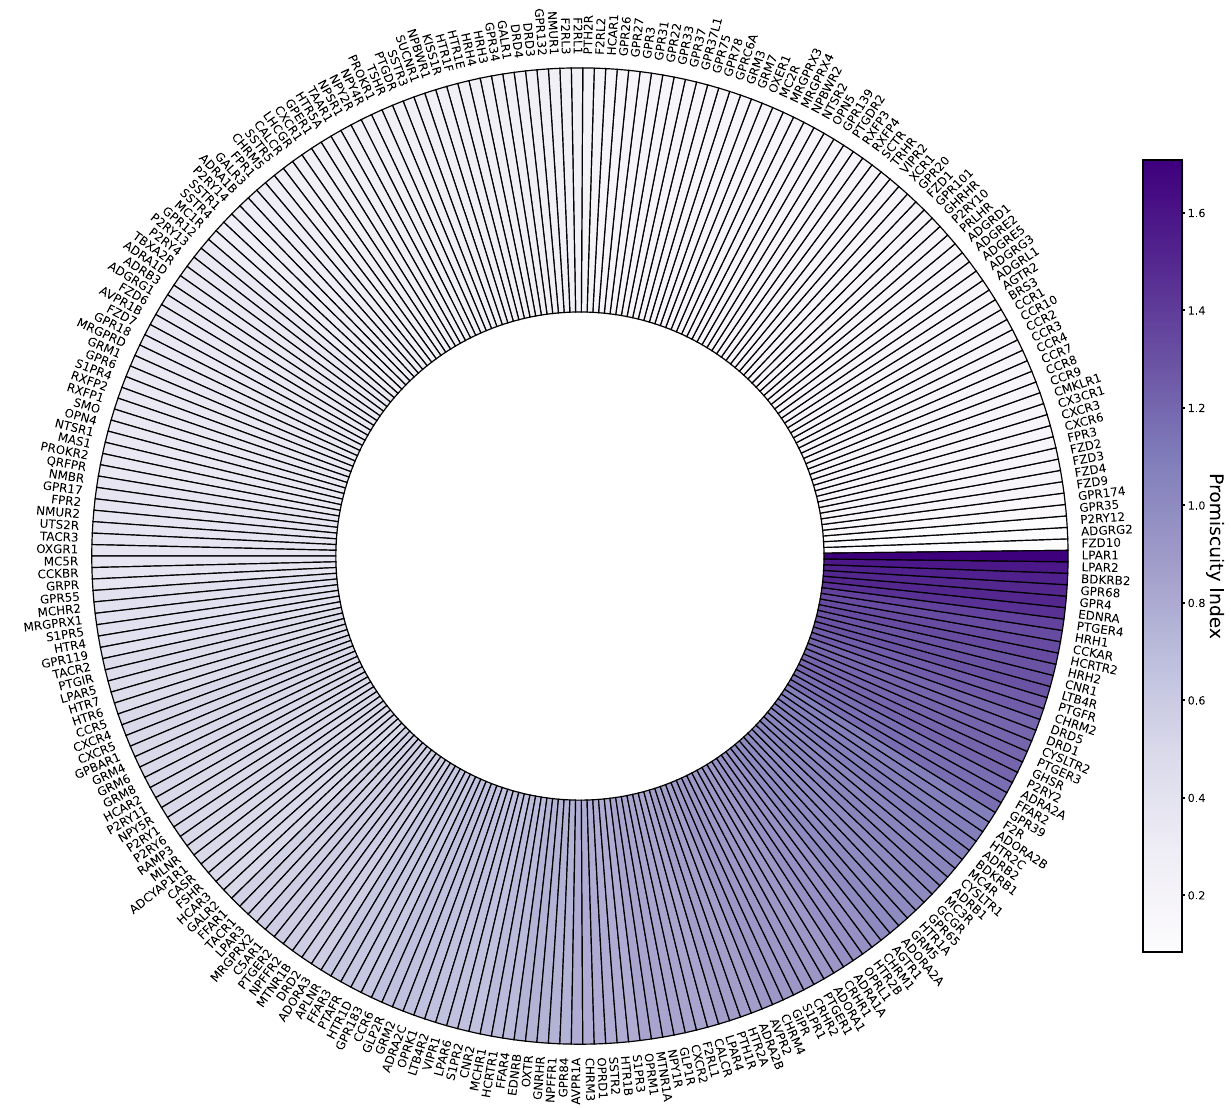
Fig. 1 | GPCRs exhibit a spectrum of coupling strength to G-proteins; from selectiveinteractionwith asingleGprotein to promiscuouscoupling acrossG protein subfamilies. GPCRs studied in Inoue et al. 11 and Avet et al. 12 along with those annotated in the IUPHAR database were compared to assess GPCR coupling selectivityacrossmajorGproteinsubfamilies. Wecalculated a “ promiscuityindex ”